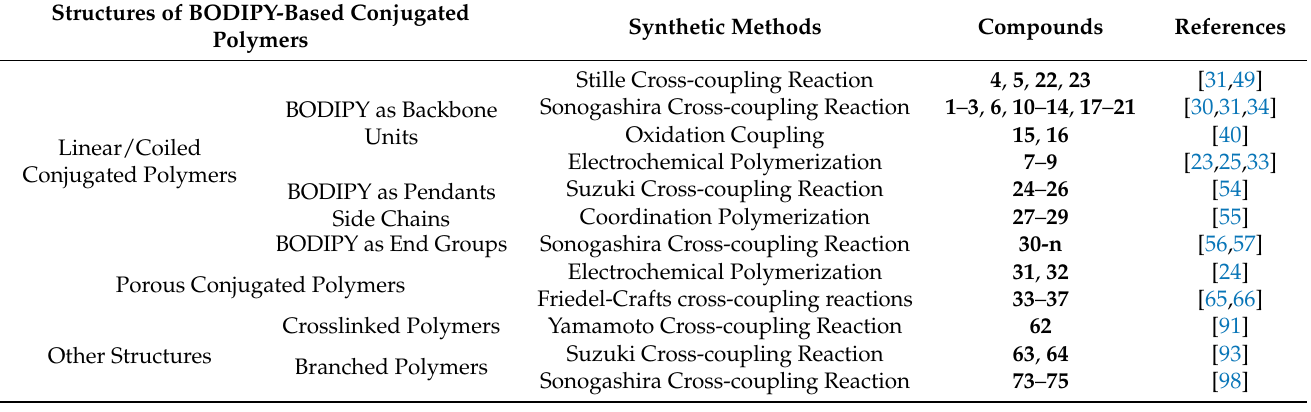
Table 1. Summary of the structures and synthetic methods of BODIPY-based conjugated polymers.